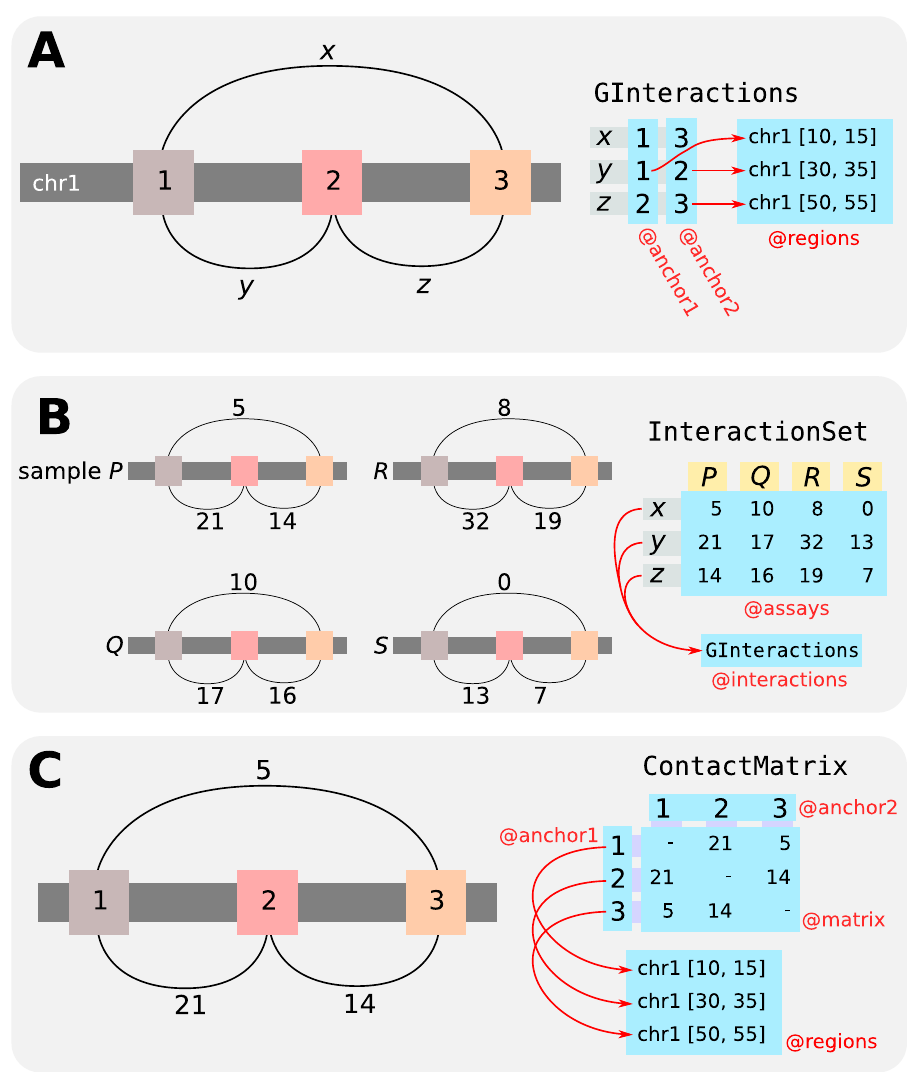
Figure 1. Overview of the classes in the InteractionSet package. Relevant slots of each class (i.e., data values stored in each object of the class) are labelled with a preceding “@”. ( A ) The GInteractions class represents pairwise interactions between genomic regions by storing pairs of anchor indices that refer to coordinates in a GenomicRanges object. ( B ) The InteractionSet class stores experimental data in an “assays” matrix where each row is an interaction and each column is a sample. Here, counts represent the number of read pairs mapped between each pair of interacting regions in each sample. ( C ) The ContactMatrix class represents the interaction space as a matrix, where each cell represents an interaction between the corresponding row/column